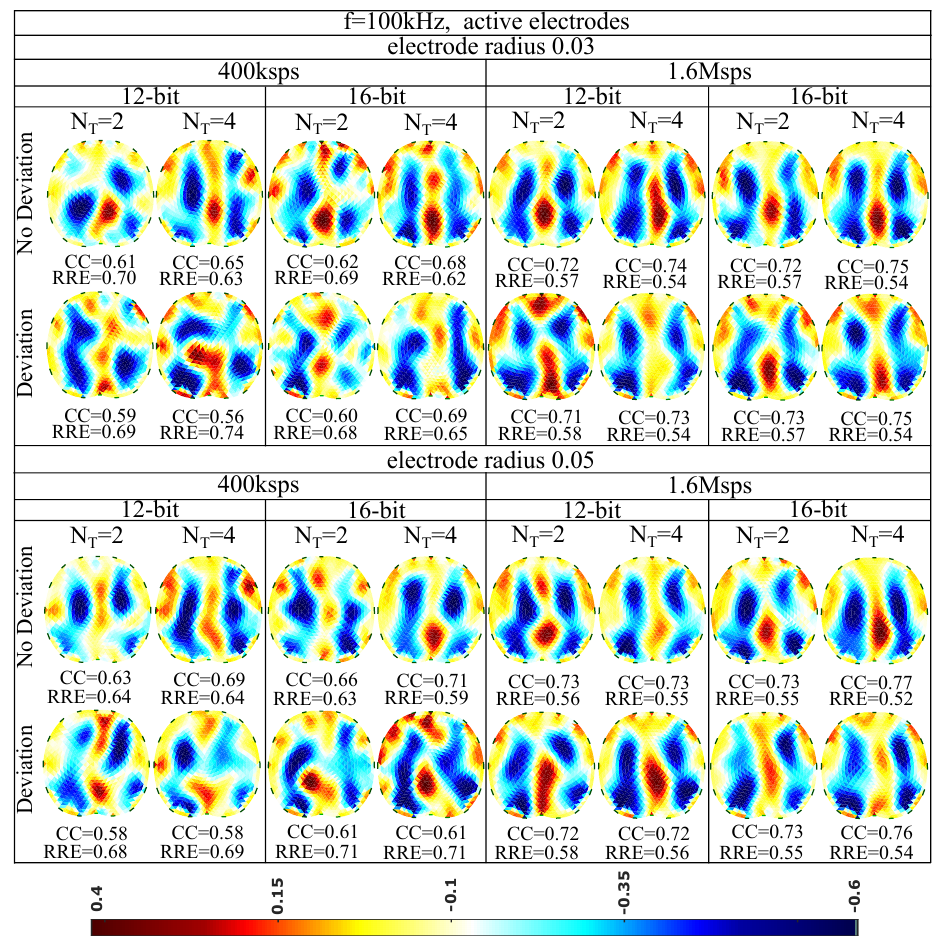
Figure 11. Simulation results for 100 kHz input signal and active electrode configuration. All further hardware configurations, as well as the corresponding CC s and RRE s, are noted in the